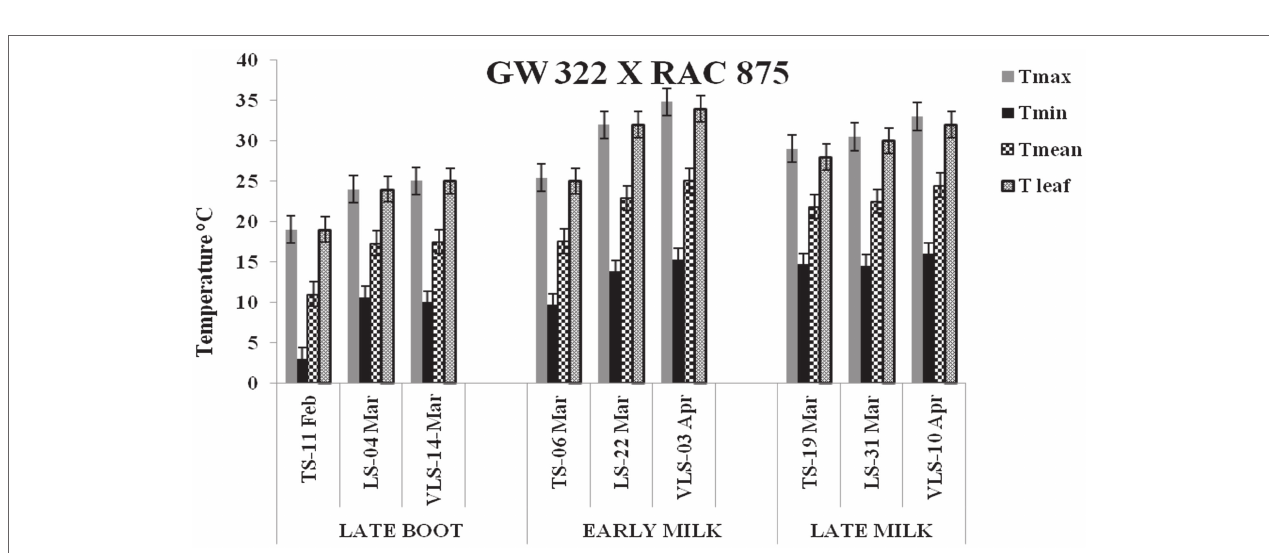
Table 1 . The magnitude of the main effects and interactions